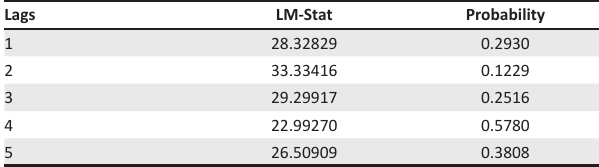
TABLE 4-A1: Vector autoregressive residual serial correlation LM tests.